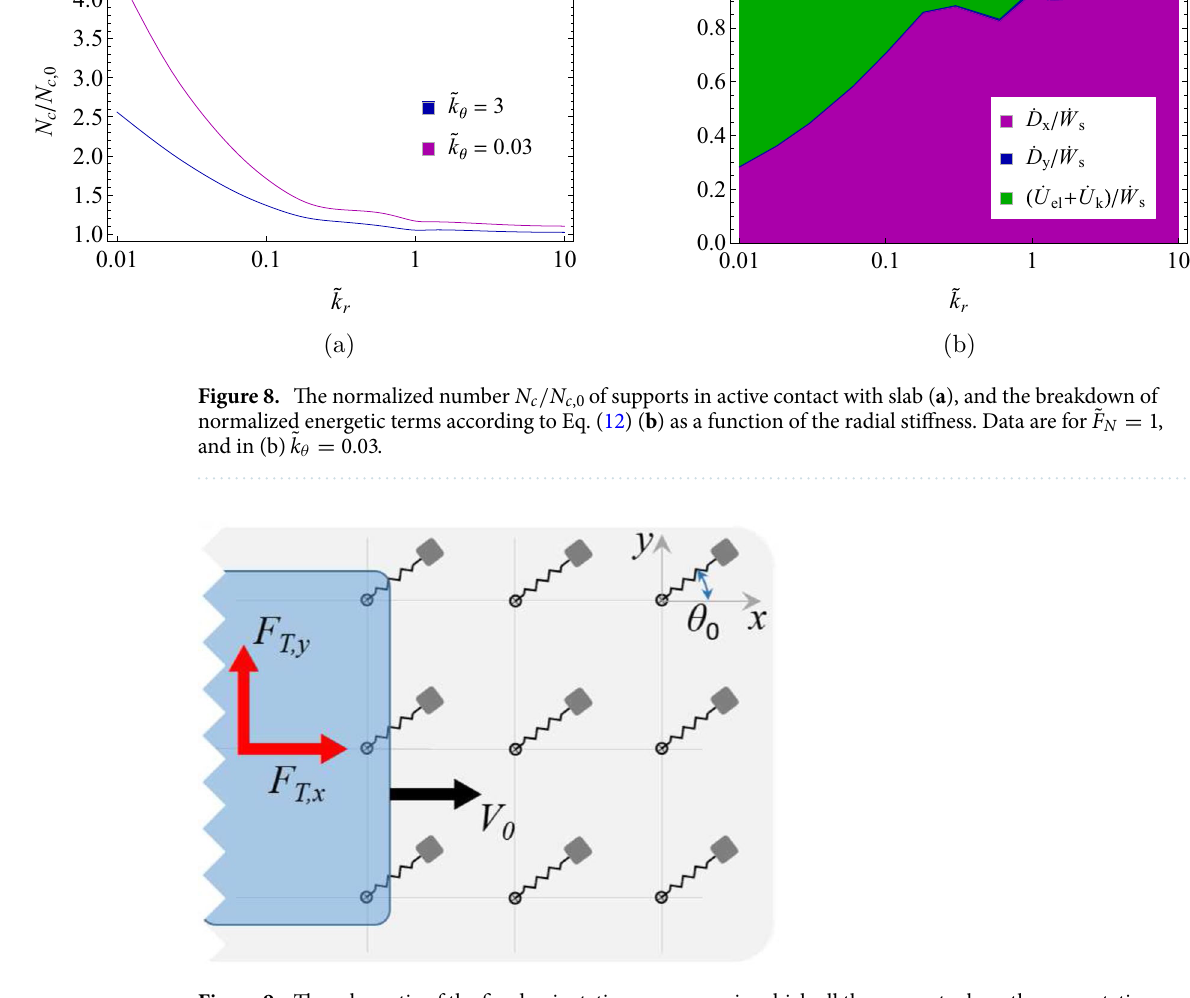
Figure 9. The schematic of the fixed-orientation array case, in which all the supports share the same static orientation θ 0 . Notably, F T , x and F T , y are the components of the force necessary to keep the slab in steady sliding against the